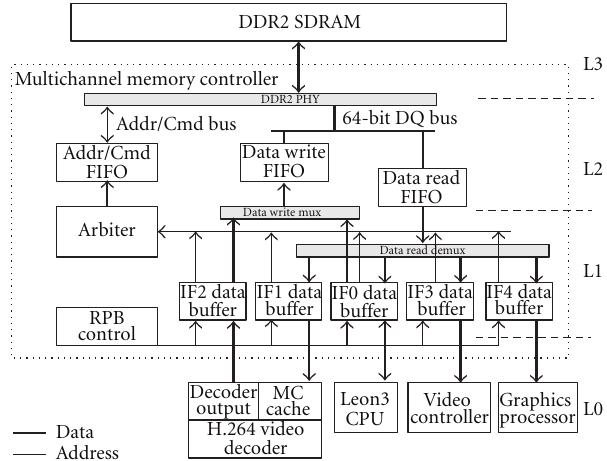
F 3: Multichannel memory controller block diagram. e memory resources are also grouped within the levels of the memory